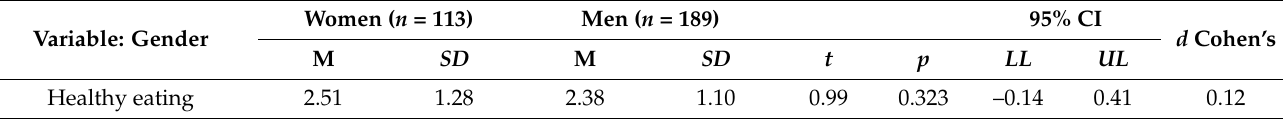
Table 6. Relationship of gender to healthy